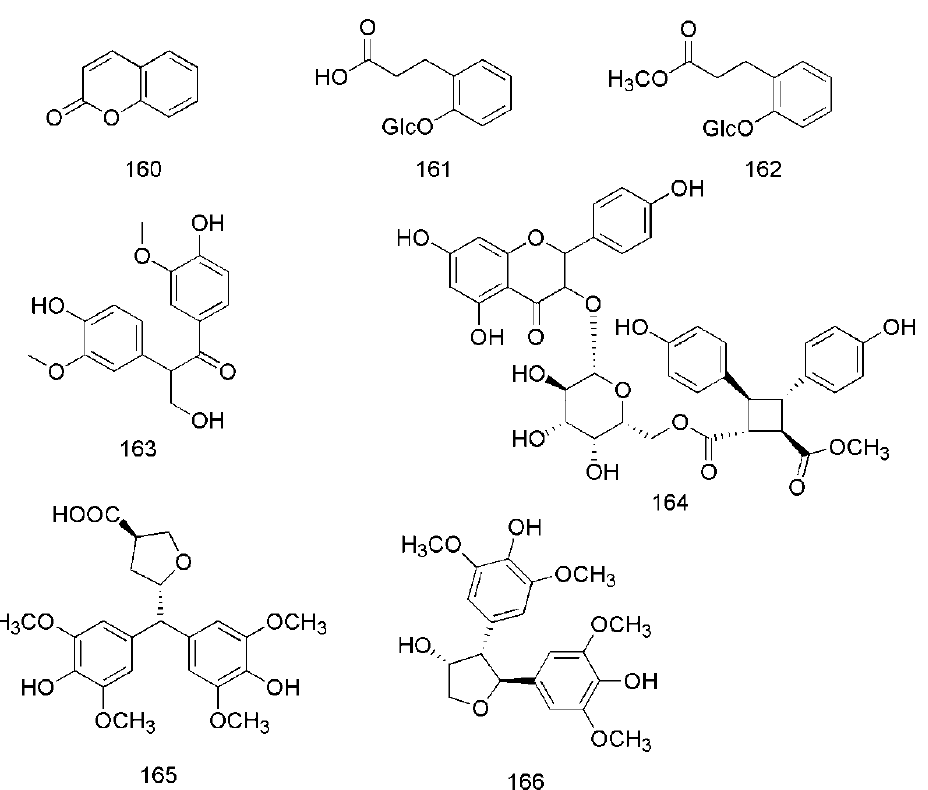
Figure 9. Chemical structures of other compounds found in C. cassia .